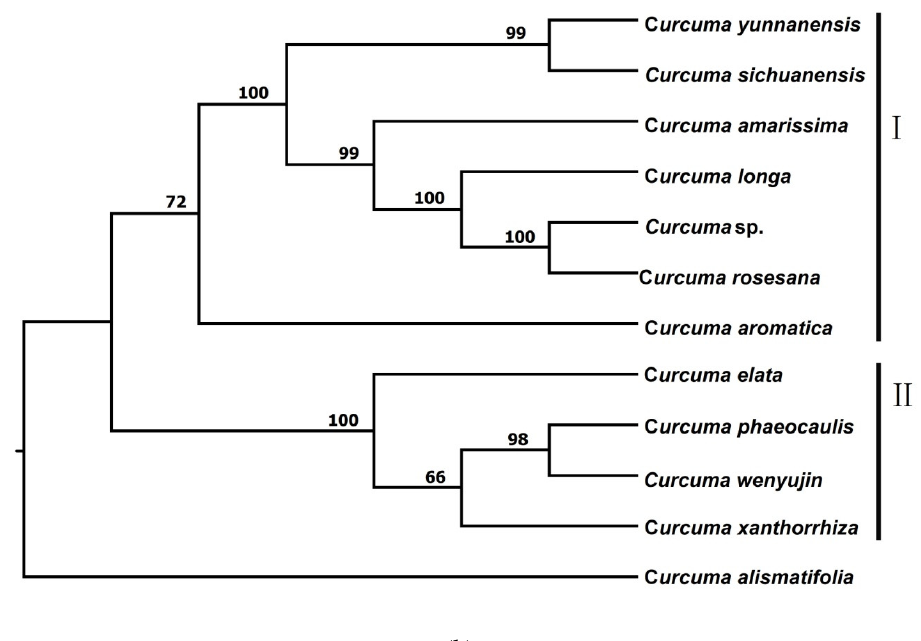
Figure 1. Phylogenetic trees of Curcuma inferred from maximum likelihood (ML) using ( a ) full concatenated super-matrix dataset and ( b ) concatenated 902 loci dataset by pyRAD. The ML bootstrap values were presented on the species clade. Only bootstrap values greater than 50 are shown. In Figure 1a, Group I consisted of C. longa , C. sichuanensis , C. sp., C. rosesana , and C. yunnanensis ; Group II consisted of C. wenyujin , C. aromatic , C. amarissima , C. phaeocaulis , C. elata , and C. xanthorrhiza . In Figure 1b, Group I consisted of C. yunnanensis , C. sichuanensis , C. sp., C. rosesana , C. longa , C. amarissima ,